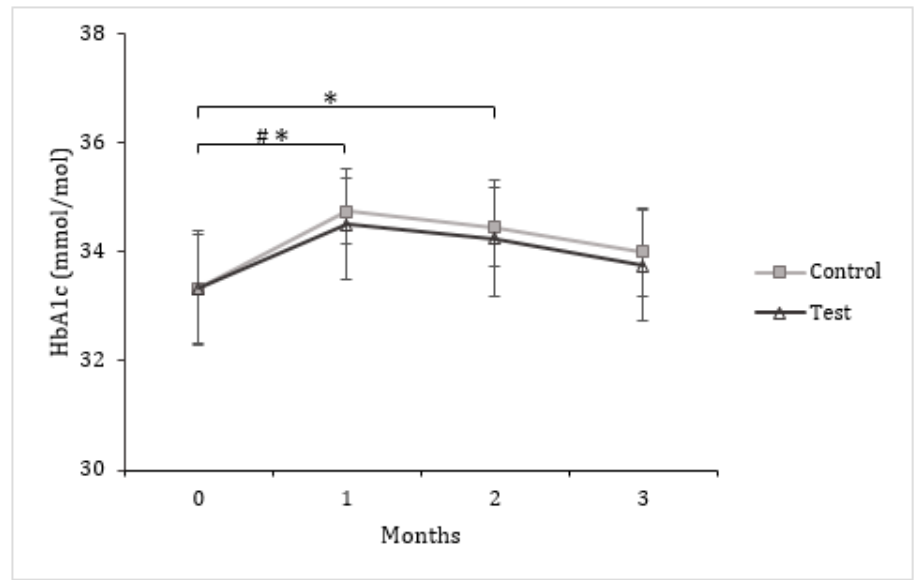
Figure 3. Glycosylated hemoglobin (HbA1c) in response to the daily consumption of two eggs enriched in oleic acid (OA) by the control group ( ⧠ ) or two eggs enriched in α -linolenic acid (ALA), docosahexaenoic acid (DHA), rumenic acid (RmA) and punicic acid (PunA) by the test group ( ∆ ), for 3 months. Mean (± SEM). Variables were logarithmically transformed prior to paired t-test, p < 0.05. (#) Significant difference compared to month 0 within the control group; (*) Significant difference compared to month 0 within the test group.